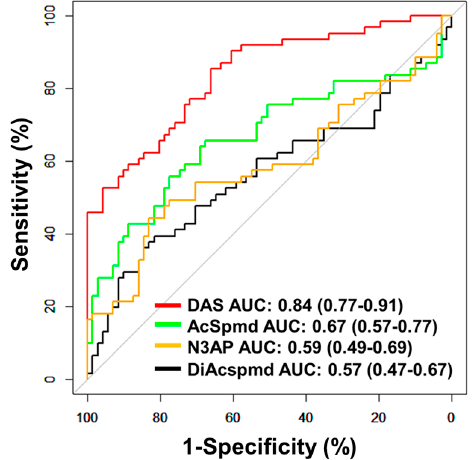
Figure 3. Classification performances of plasma polyamines in the validation set. The area under the curve (AUC) of individual polyamines for delineating all cases ( n = 61) from healthy controls ( n = 71).